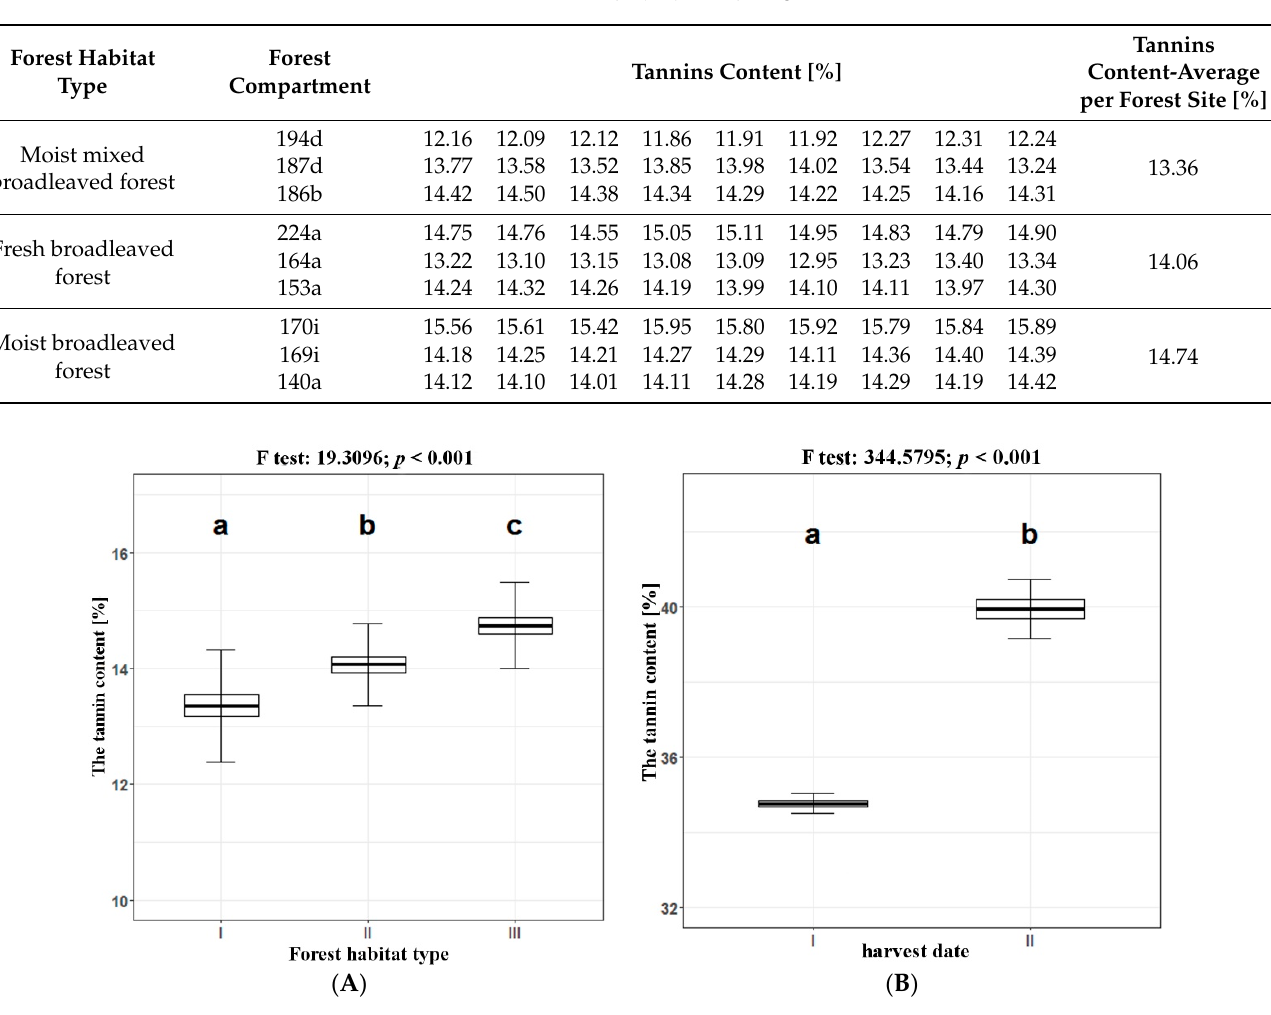
Table 2. Content of tannins in Cynips quercusfolii gall nuts.